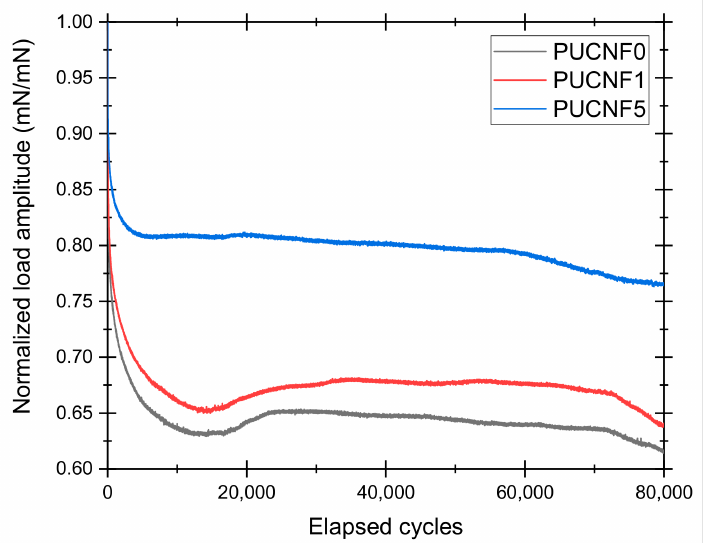
Figure 5. Normalized load amplitude of PCUNF0, PCUNF1, and PCUNF5 as a function of the elapsed cycles.